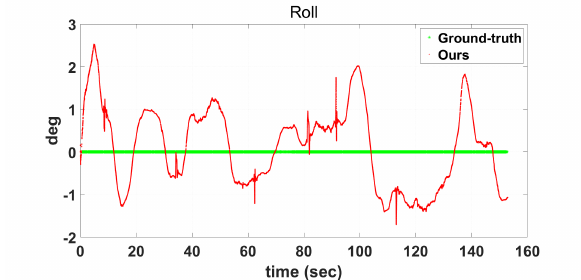
Figure 5. Comparison of our estimated roll angle with the ground-truth for the home1 consequence.